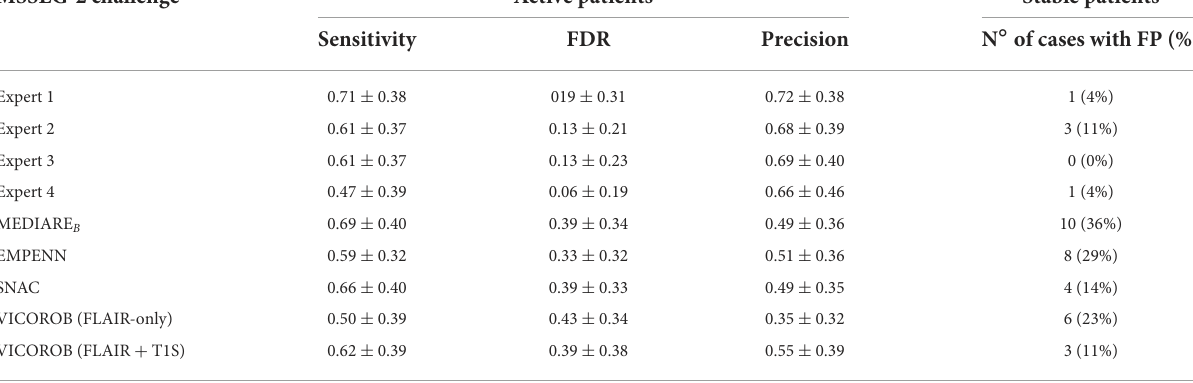
TABLE 3 Results of the MSSEG-2 challenge 2021.